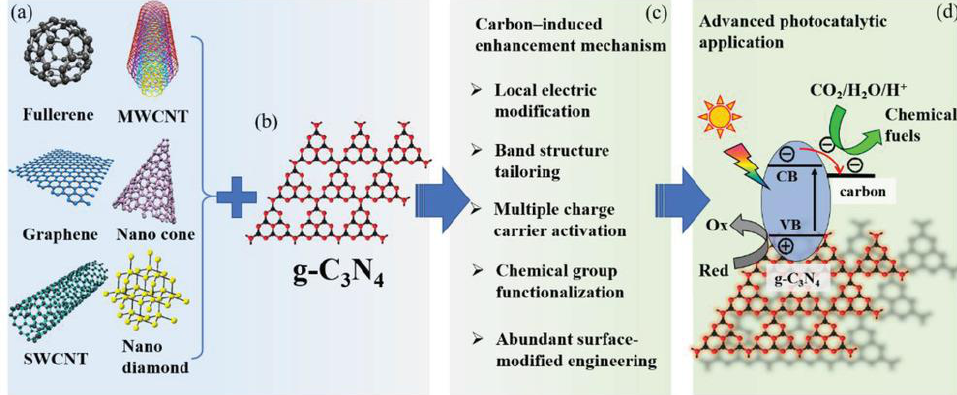
Figure 9. Schematic illustration of enhancement mechanism over carbon-induced g-C 3 N 4 nano- composites in photocatalytic action. ( a ) Different types of carbon materials. ( b ) Chemical structure of g-C 3 N 4 ; black and red dots represent C and N, respectively. ( c ) The enhanced photocatalytic mecha- nisms and ( d ) energetic photocatalytic application of carbon-induced metal-free g-C 3 N 4 nanocom- posites. Reprinted with permission from Ref. [121]. Copyright 2020 John Wiley and